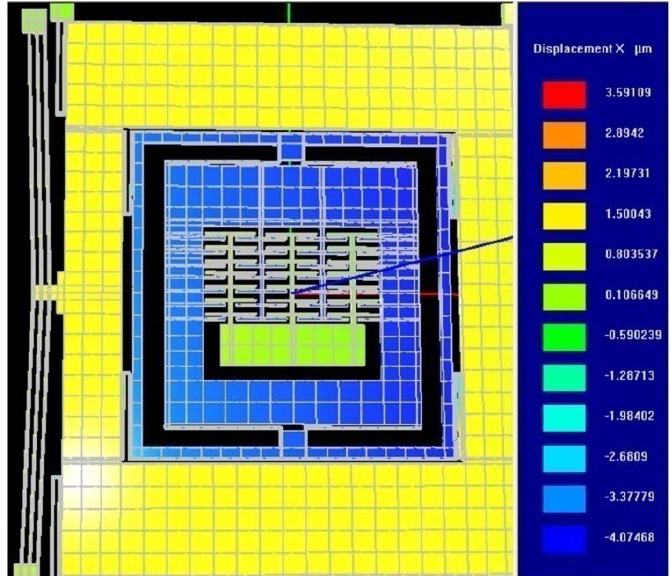
Figure 16. Displacement profile of the 3-DoF micromachined vibratory gyroscope excited by a sinusoidal voltage of 0.5V amplitude and a frequency of 1.77 kHz. Due to mechanical m m  (blue) achieves a displacement of 4.07 μ m keeping amplification, the passive mass 2 f the active mass